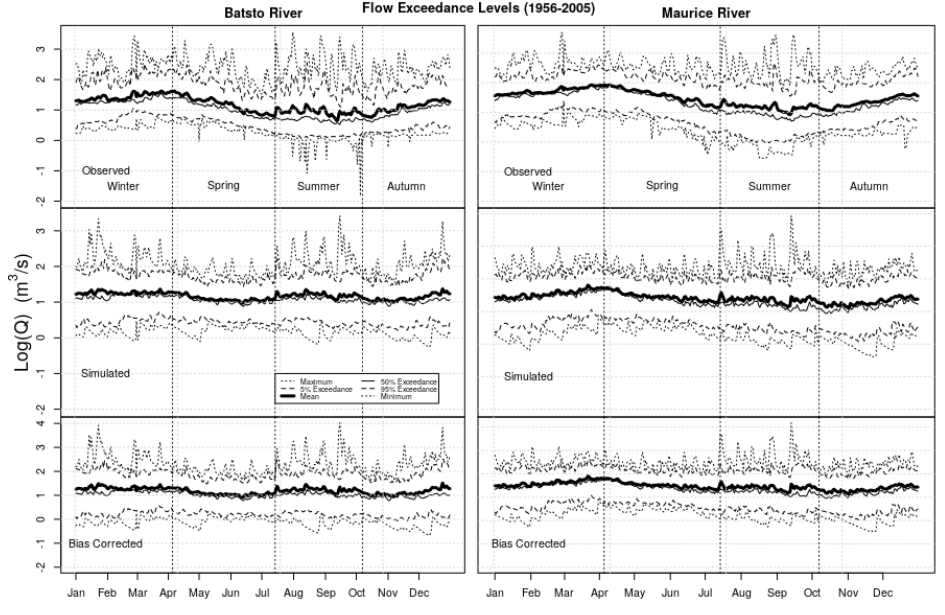
Figure 2. Flow exceedance for water years 1956–2005 for the Batsto (left) and Maurice Rivers. Plots show from top to bottom: observed, simulated uncorrected (UC), and bias-corrected (BC) for each river. The lower curve is the minimum flow in the record; the next curve is the 95% exceedance level (flow exceeded 95% of the time); then the median flow, then mean flow (thick line), then 5% exceedance, then the maximum flow in the record for each day of the